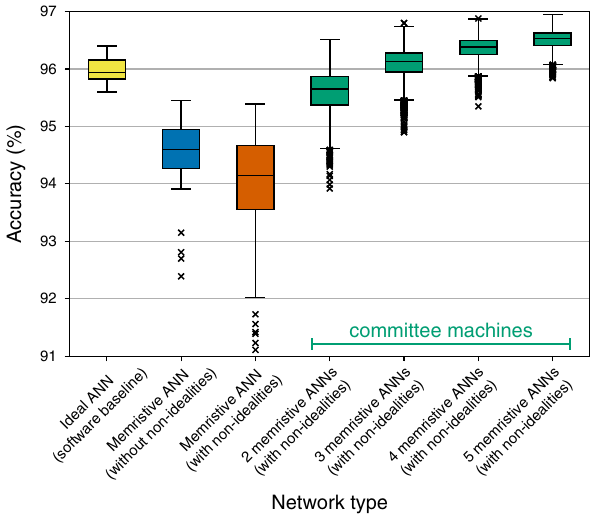
Fig. 6 Accuracy of committee machines when using Ta 2 O 5 devices.